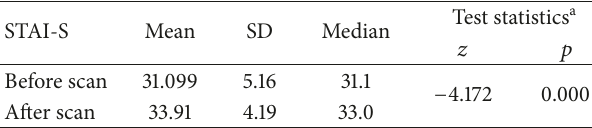
Test statistics a 𝑧 𝑝 4.172 0.000